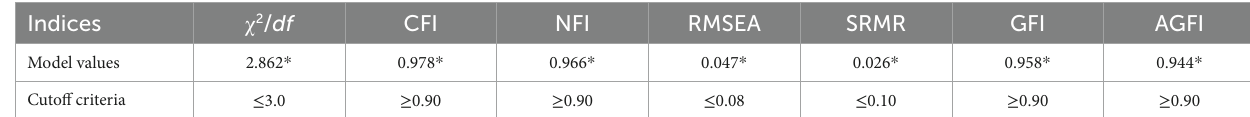
TABLE 9 Model fit indices of model 5.